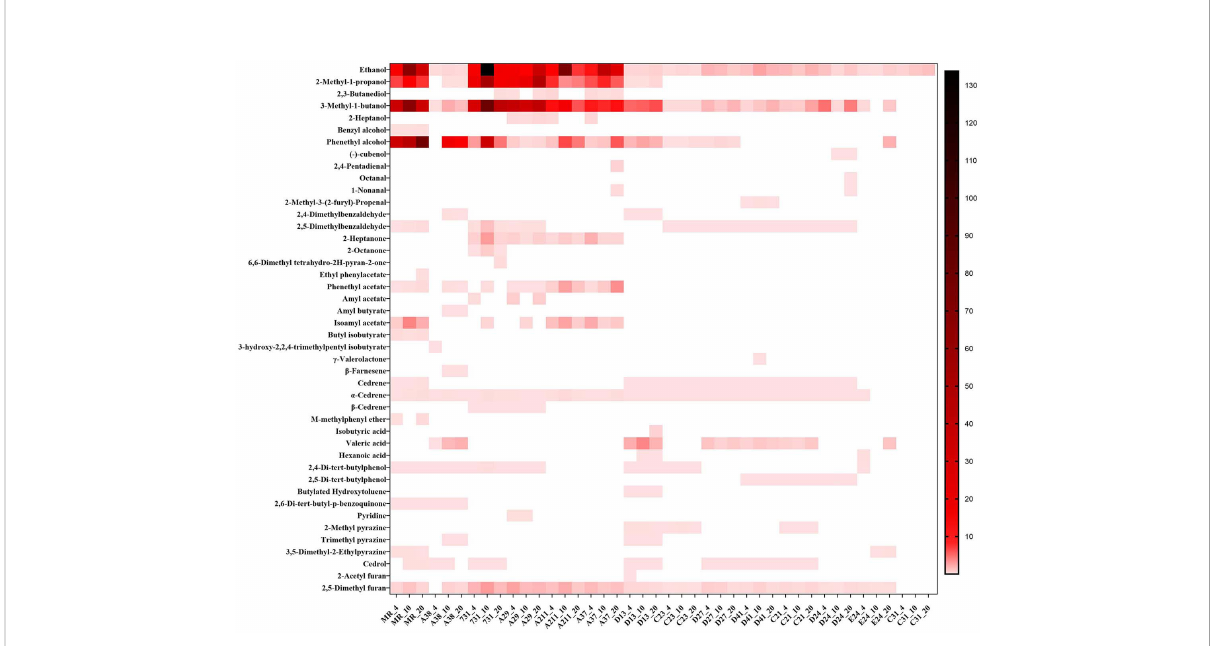
FIGURE 2 Composition of yeast mVOCs at varying temperatures. X-axis indicates yeast strains and incubation temperature; Y-axis indicates detected mVOCs; ‘ _4 ’ means incubate under 4°C; ‘ _10 ’ means incubate under 10°C; ‘ _20 ’ means incubate under 20°C; n=3; different color means different relative abundance: the darker the color block was, the more relative abundance the material